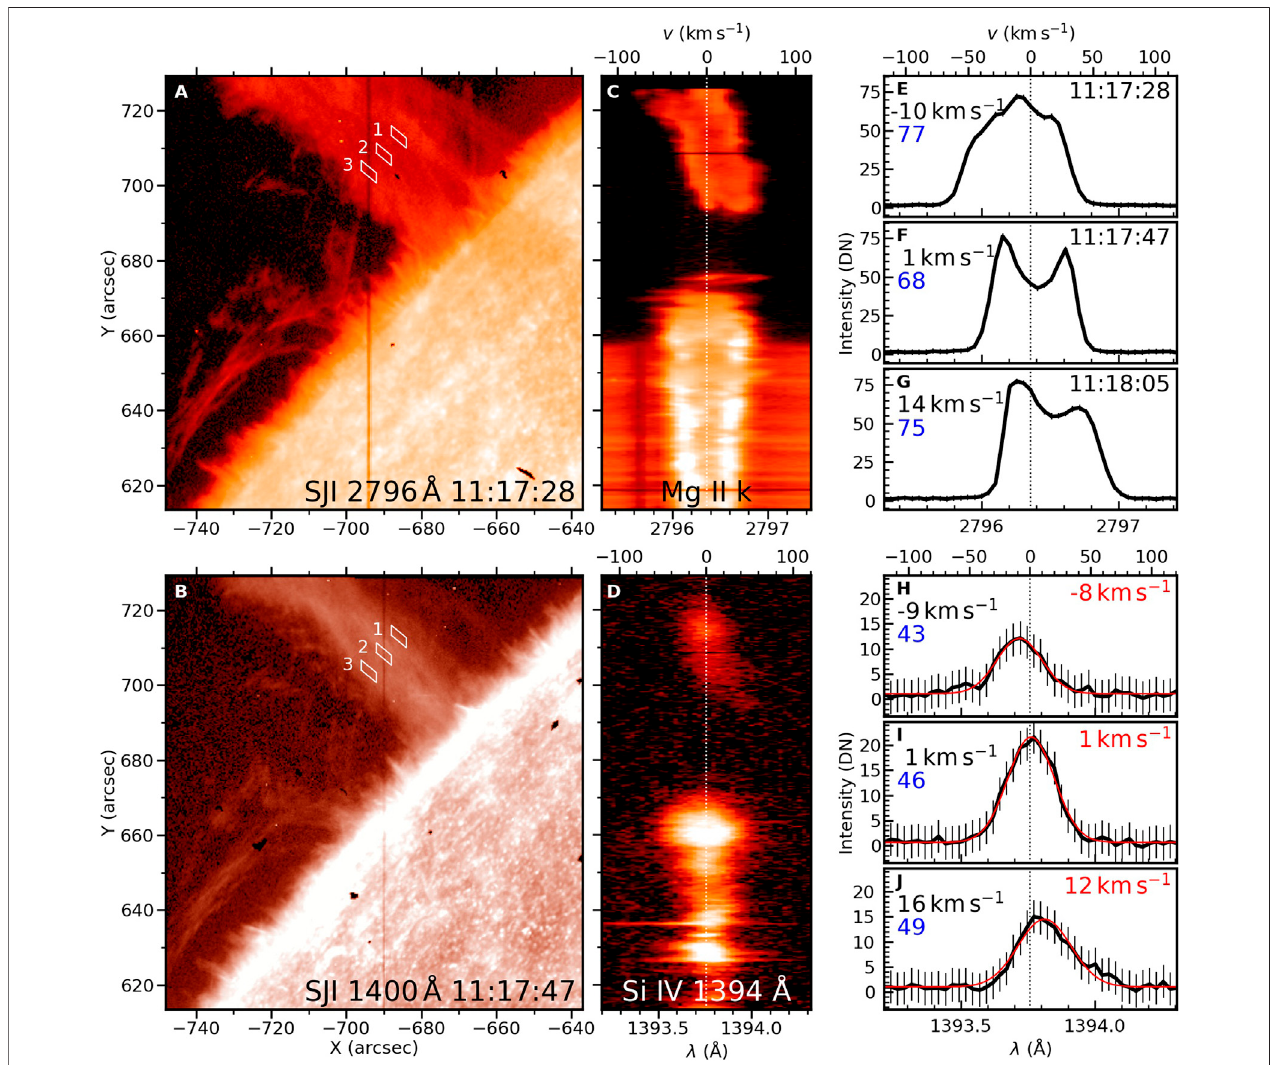
FIGURE3 | Spectral observations around 11:17 UT. First column: IRIS SJIs. Second column: images ofthespectra at theslit positionas shown in panel (A) . Third column:average spectral pro fi les from boxes 1-3tbox1-3 in panels (A – B) , sequentially. The fi rst row isfor Mg II observationsand the second row is for theSi iv window. Theverticaldottedlinesin (C – J) markthepositionsofrestwavelengths.Inpanels (E – J) ,DopplervelocitiesderivedfromtheCOGmethod(blackfonts)andFWHMsinthe units of “ km s − 1 ” (blue fonts) are noted in left. In panels (H – J) , the Doppler velocities derived from Gaussian fi tting (red curves) are marked in right (red fonts).